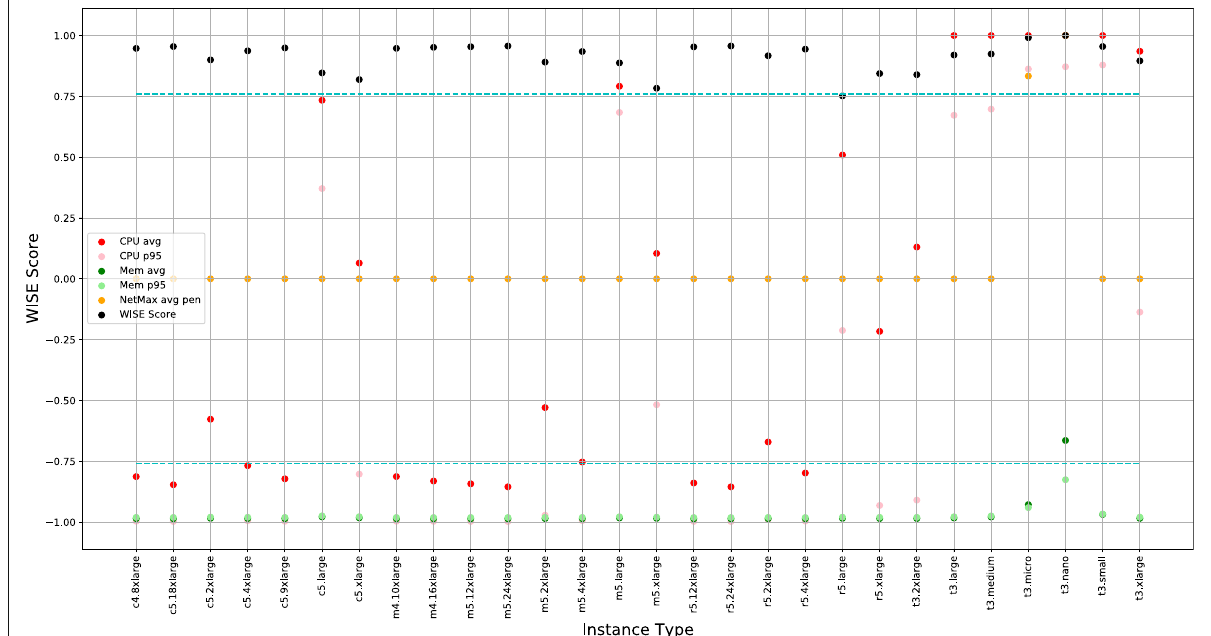
Fig. 5 WISE scores using the hyperbolic tangent function and (cid:4) 2 -norm for MongoDB